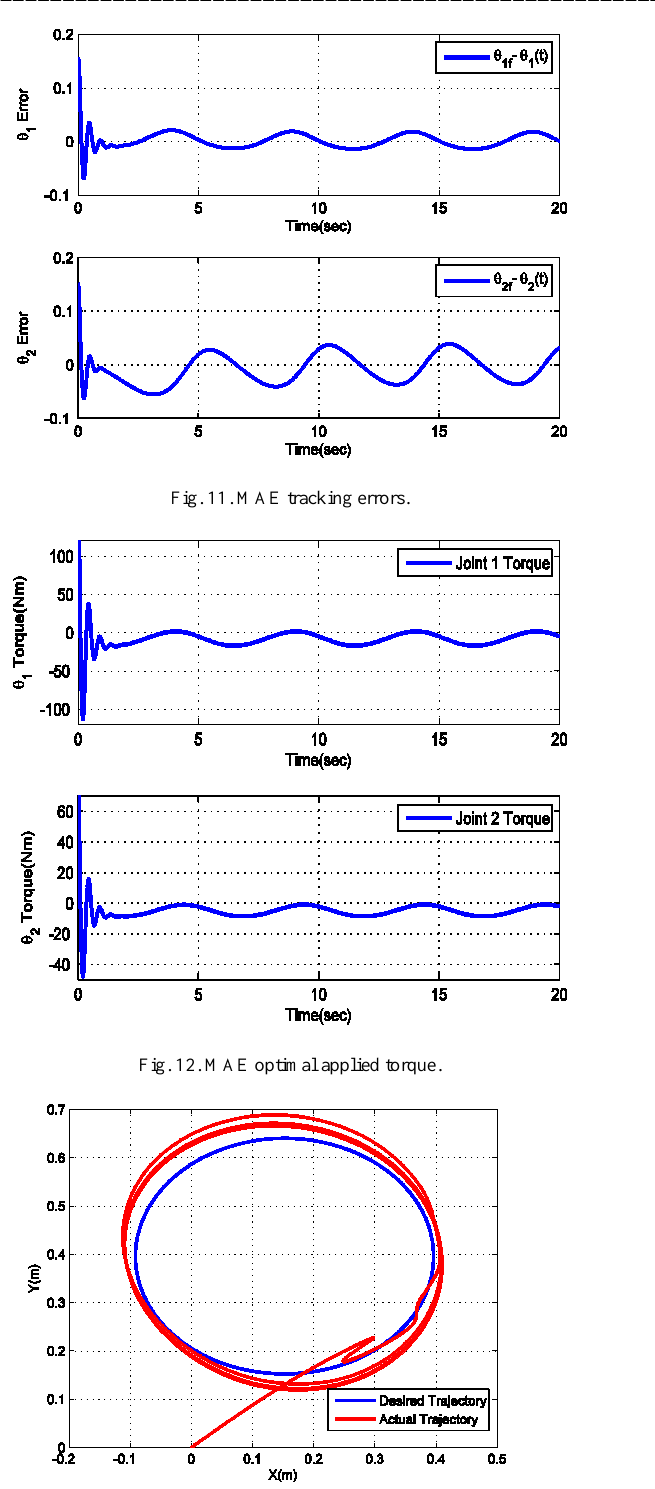
Fig. 16. RBECE tracking